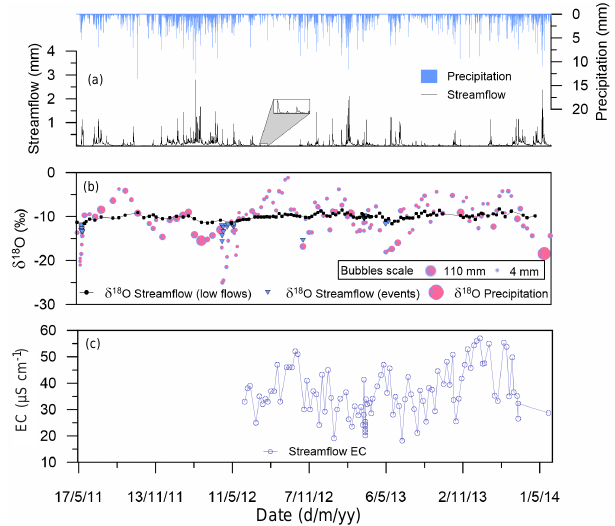
Figure 2. (a) Hourly precipitation and unit area streamflow; (b) δ 18 O isotopic composition in precipitation and streamflow for 3 years (May 2011 to May 2014); and (c) electrical conductivity for 2 years (May 2012 to May 2014) at the catchment outlet (M8; see location in Fig. 2). The size of the bubbles in plot (b) indicates the relative cumulative rainfall in millimeters for each collected